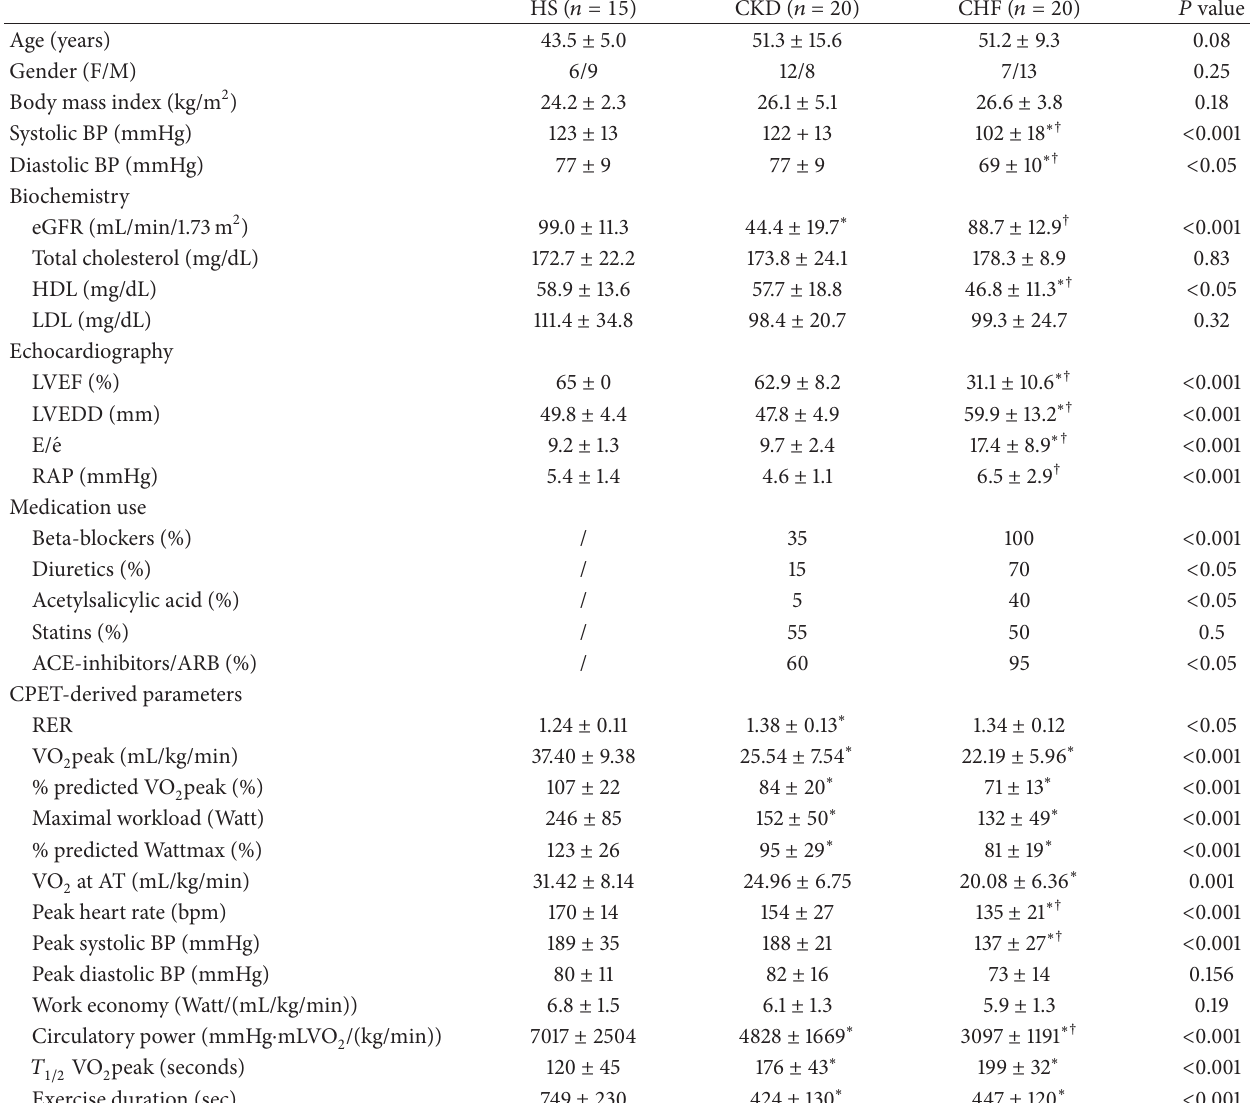
Table 1: Baseline characteristics of